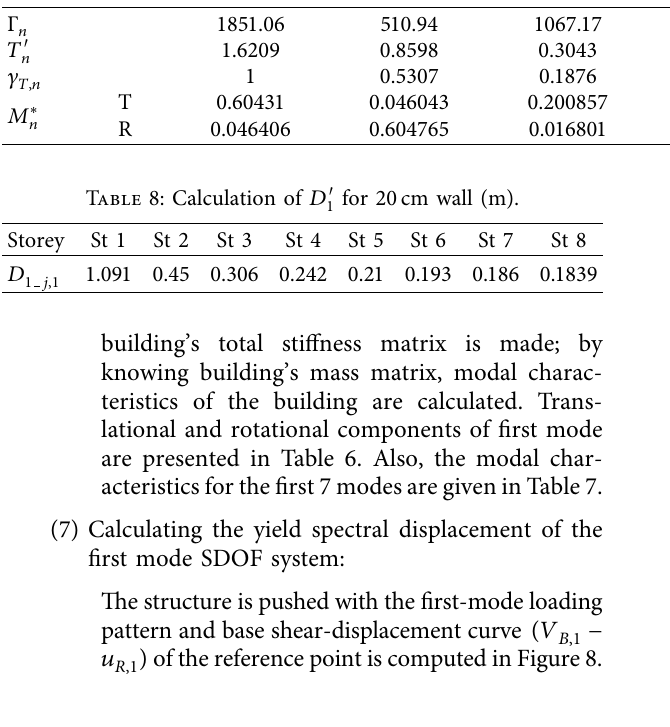
Table 7: Modal characteristics.